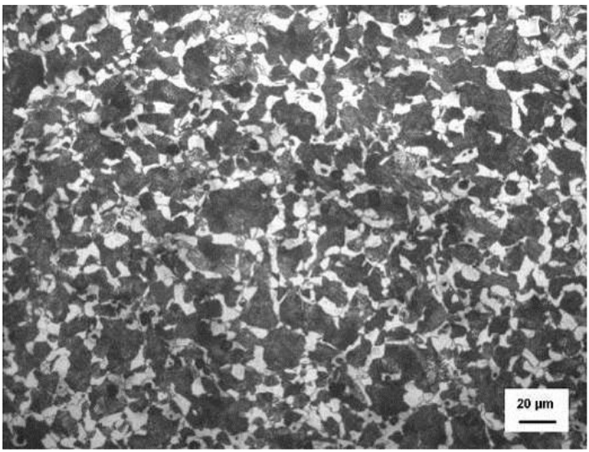
Figure 1: The original microstructure of the 49MnVS3 non-quenched and